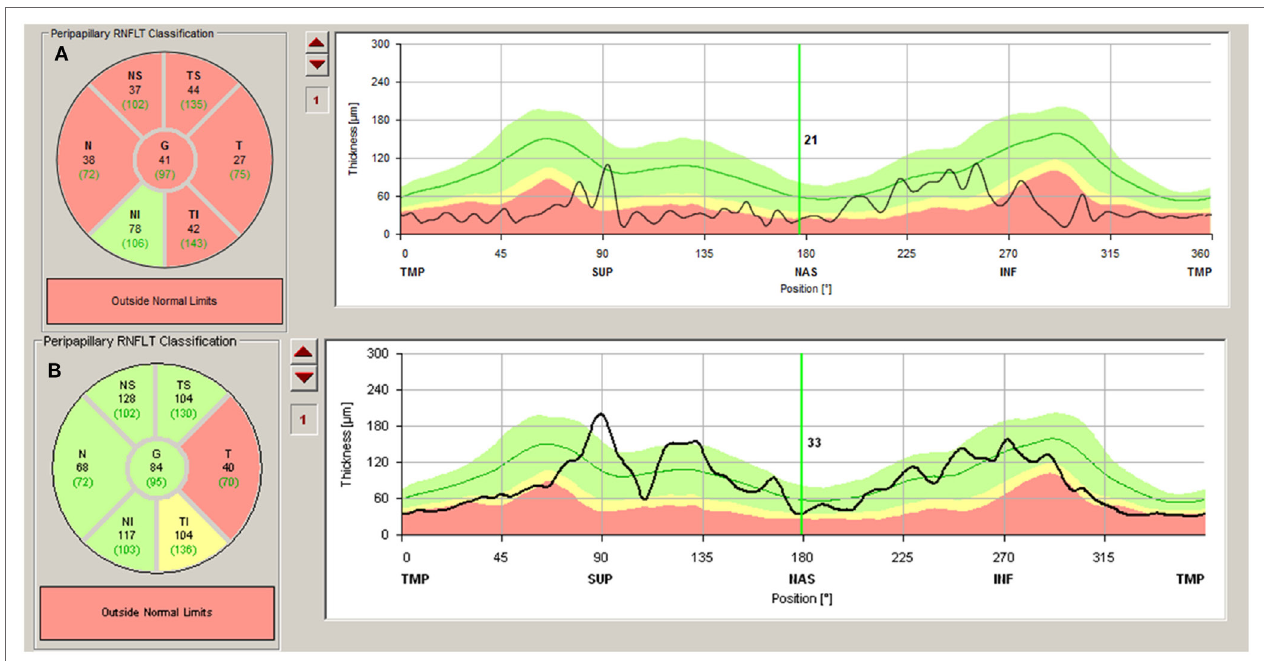
FigURe 1 | (a) Severe atrophy of peripapillary retinal nerve fiber layer (pRNFL) after optic neuritis (ON) in a neuromyelitis optica spectrum disorders patient. (b) Atrophy of pRNFL temporal quadrant in a multiple sclerosis patient without history of